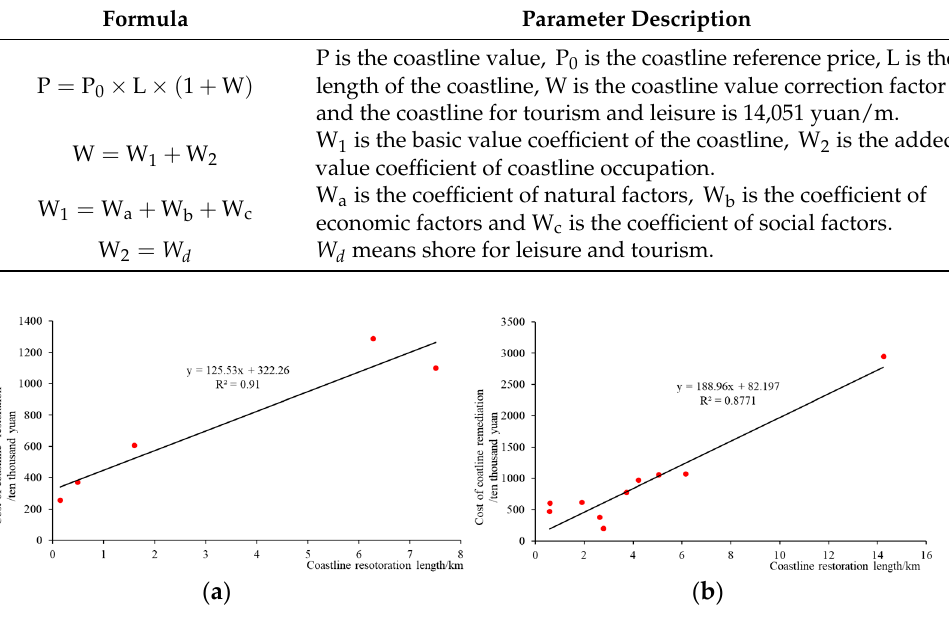
Table A2. Evaluation system of tourism and recreation benefits after coastline reconstruction in Zhejiang province.